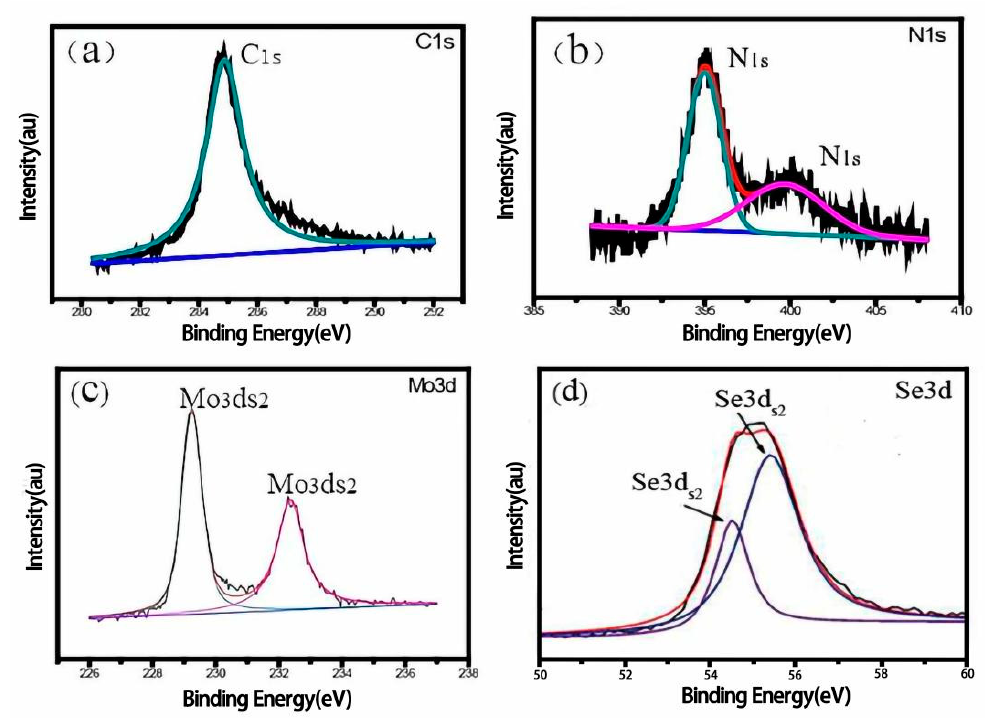
Figure 3. ( a ) The XPS C 1s spectrum of MoSe 2 /N&B-BCM, ( b ) the XPS N 1s spectrum of MoSe 2 /N&B-BCM, ( c ) the XPS Mo 3d spectrum of MoSe 2 /N&B-BCM, and ( d ) the XPS Se 3d spectrum of MoSe 2 /N&B-BCM.